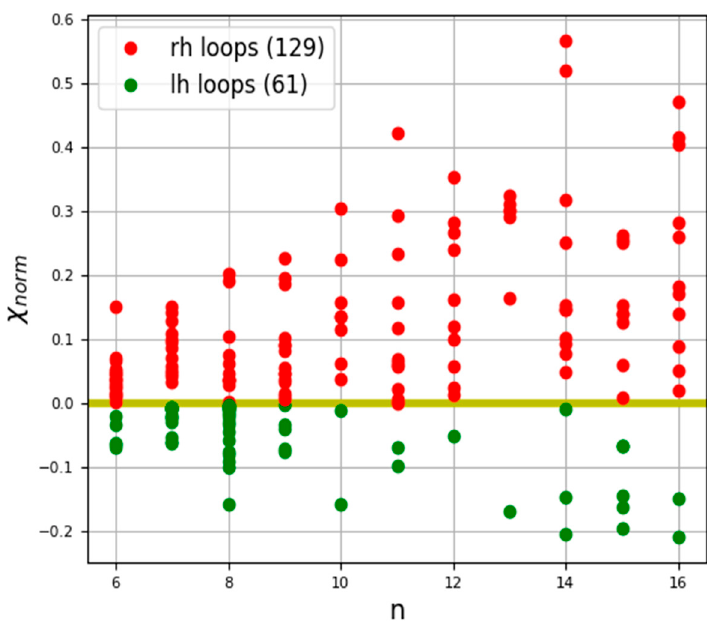
Figure 12. Normalized chirality map of Ω -loops. The horizontal axis is the length of the secondary structure in amino acid residues, the vertical axis is the normalized chirality value; rh–right-handed structures, lh–left-handed structures.